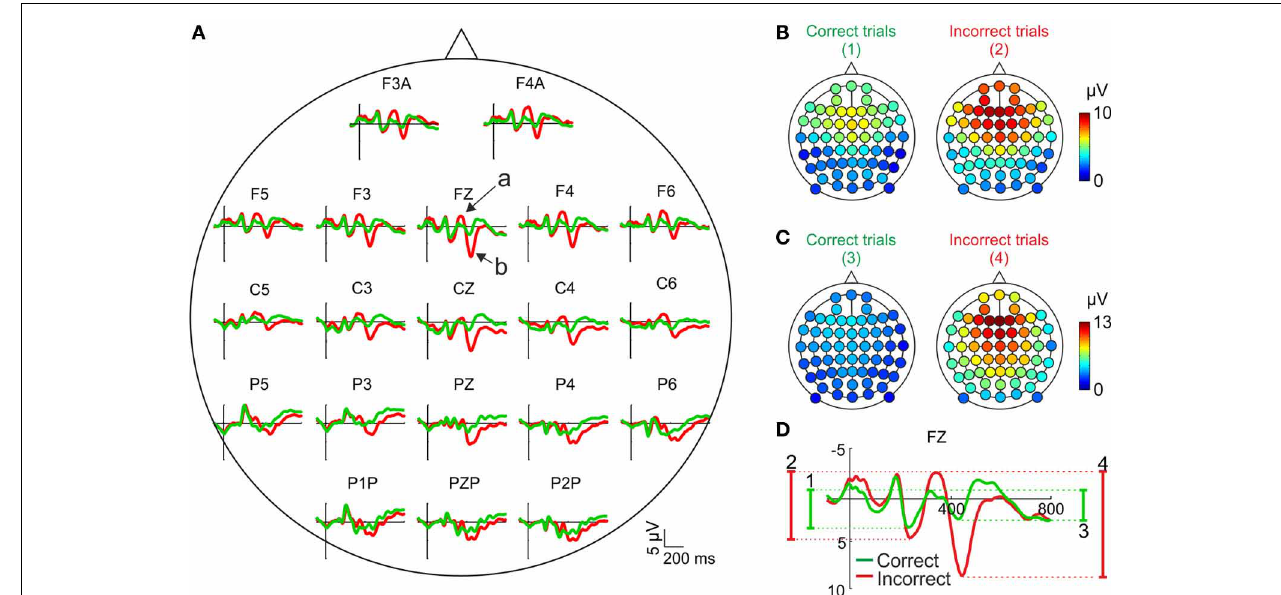
FIGURE 2 | Scalp distribution of the EEG activity after feedback presentation. (A) Grand mean, averaged across the sample ( N = 12), for correct (green traces) and incorrect (red traces) trials in the principal electrode positions. Time (y-axis) is from − 100 to 800ms with respect to feedback onset (signaled by the x-axis). Arrows labeled “a” and “b” signal the negative and positive deflections, respectively. Negative voltages are plotted upwards